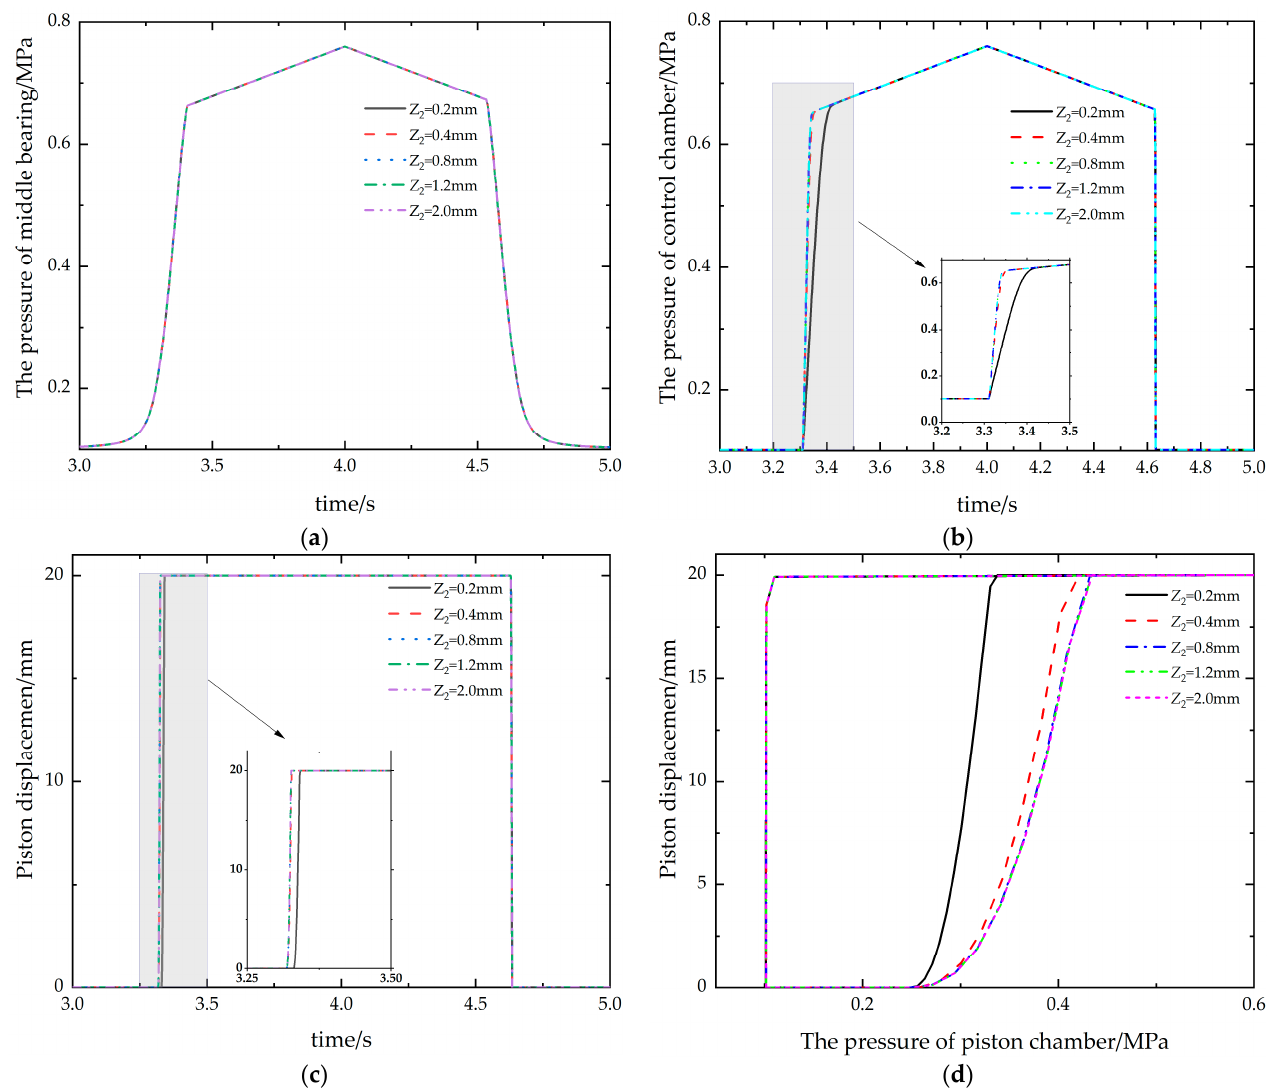
Figure 12. Opening and closing characteristics of valve with different front throttle orifice diameters: ( a ) The variation law of middle bearing pressure with time; ( b ) Control of the change in cavity pressure with time; ( c ) The variation law of piston displacement with time; ( d ) The variation of piston displacement with pressure in control